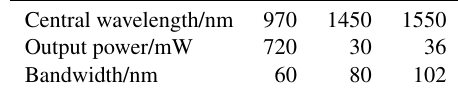
Table 6. Characteristics of the LED sources.